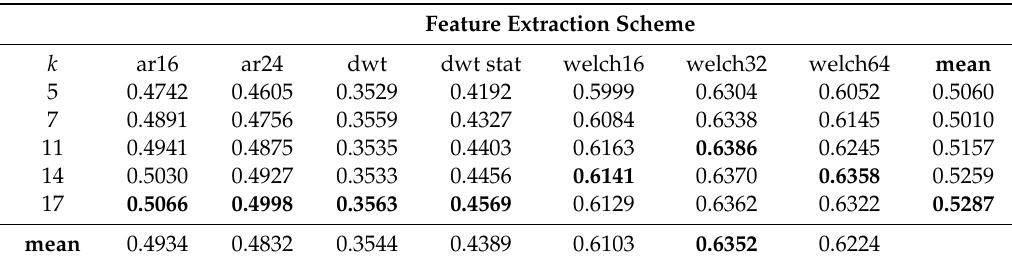
Table 2. Accuracy of test data classification with k -NN classifiers for chosen values of k